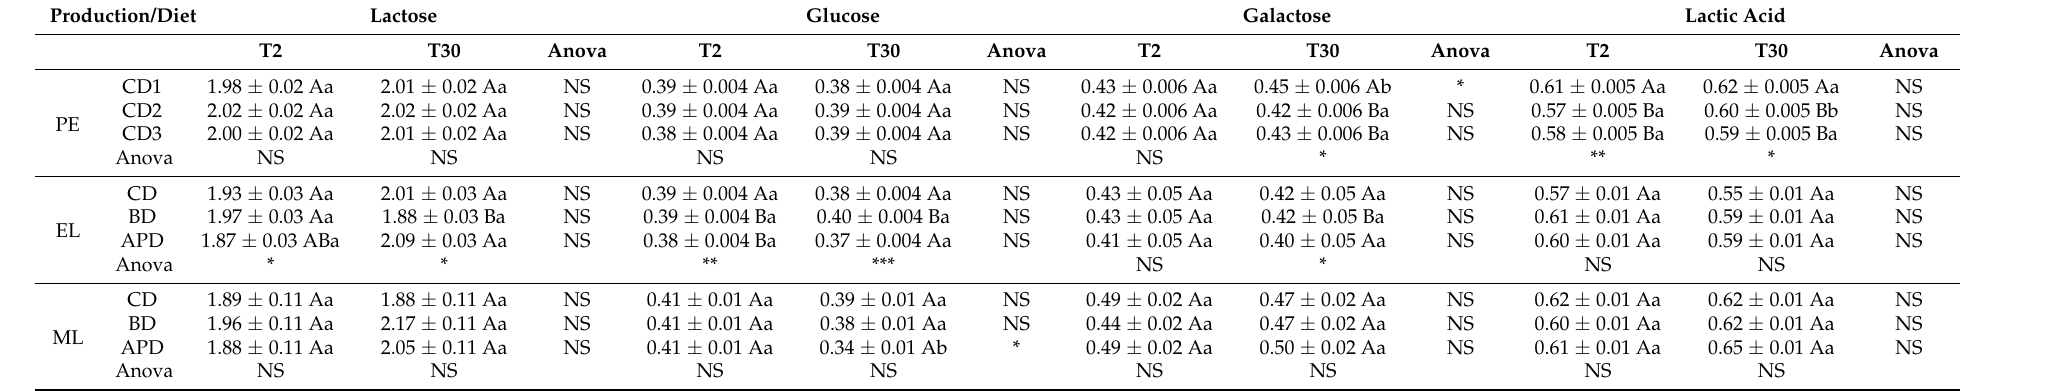
Table 4. Sugars and lactic acid content in fermented milk manufactured and stored for 2 and 30 days with milk from Murciana-Granadinas goats fed differentiated diets, using a thermophilic (YO-MIX TM 300) starter